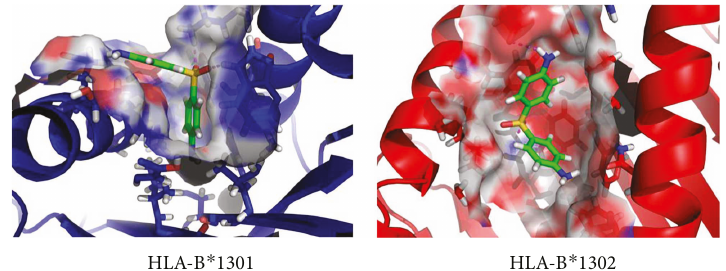
Figure 4: Dapsone binds more tightly to HLA-B ∗ 13:01 than to 13:02. Binding models before molecular dynamic simulations for dapsone – HLA-B ∗ 13:01 (blue) and dapsone – HLA-B ∗ 13:02 (red), based on observations of the stick representation of their HLA three-dimensional homology models. Dapsone (green) inserts are deeper in HLA-B ∗ 13:01 (blue) than in HLA-B ∗ 13:02